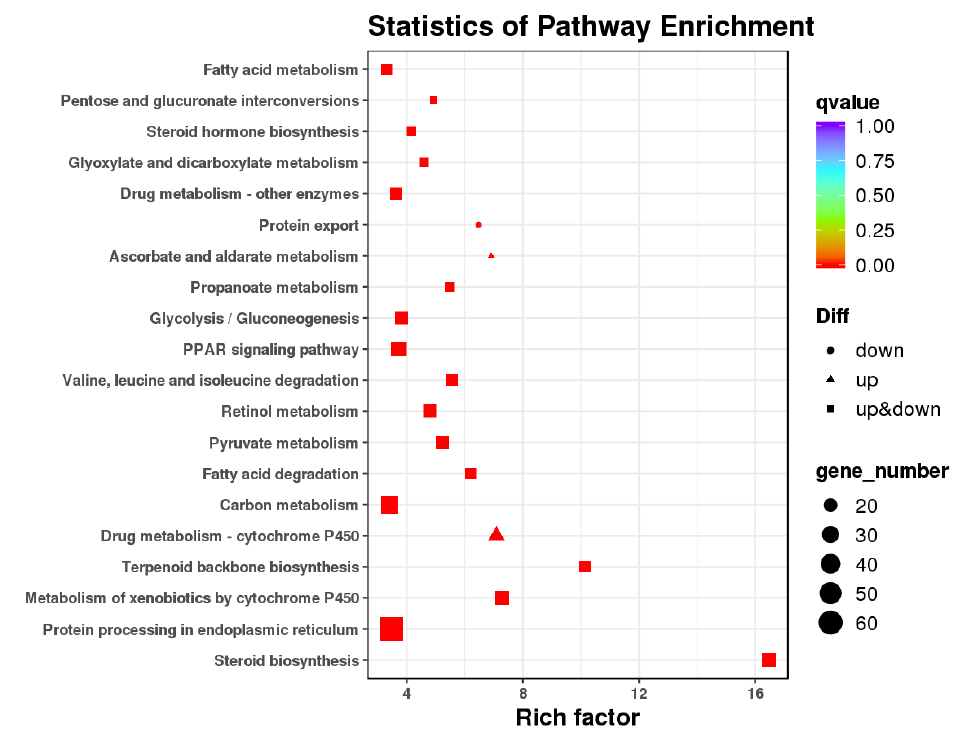
Figure 3. Top 20 statistics of pathway enrichment based on the differentially expressed genes in goldfish after exposure to trichloroisocyanuric acid. Rich Factor is the ratio of differentially expressed gene numbers noted in this pathway term to all gene numbers noted in this pathway term; the “up” indicates that only upregulated genes are enriched in this pathway, “down” indicates that only downregulated genes are enriched in this pathway, and “up and down” indicates that both upregulated and downregulated genes are enriched in this pathway. All top pathways had a q-value less than 0.0001.